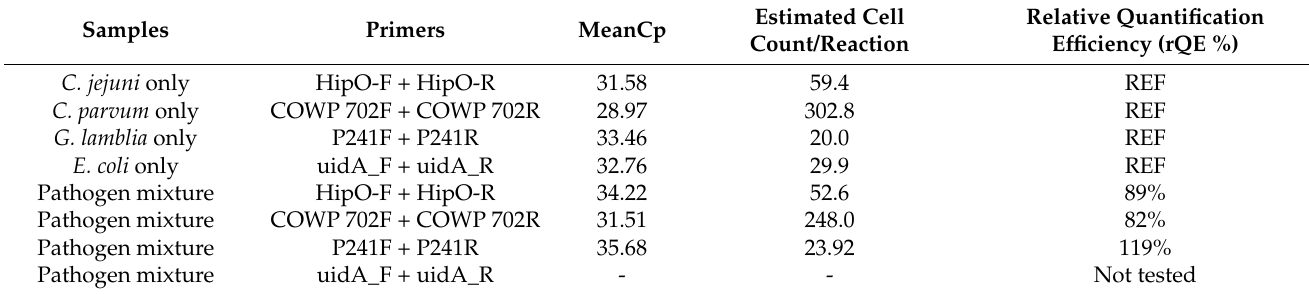
Table 3. Performance of the qPCR primers in a mixed-pathogen environment. Pathogen mixture contained C. jejuni , C. parvum , G. lamblia , and E. coli in a 10 mL culture. Relative quantification efficiency (rQE%) determined used single pathogen cell count as benchmark (REF) and calculated as: rQE% = QE in mixed-pathogen sample/QE in single-pathogen sample × 100%. Primers against E. coli were not tested but have been included in the 100 mL-scale test (Table 6). See Section 3.5 quantification and statistical analysis for full